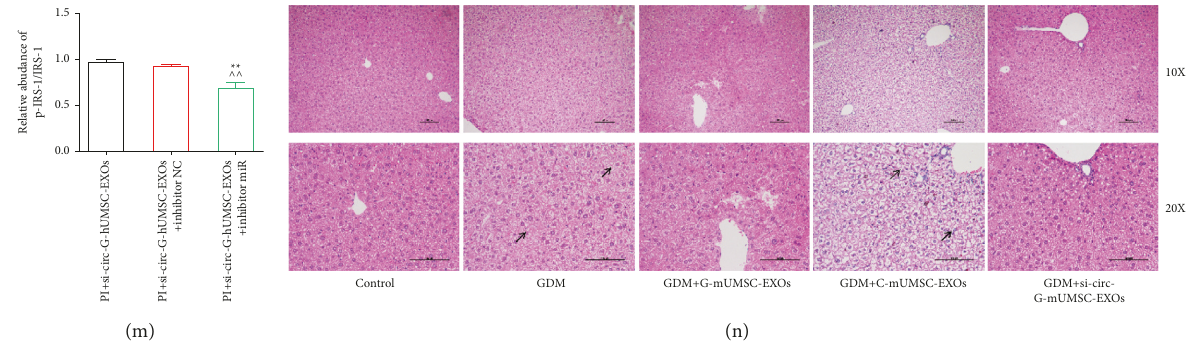
Figure 6: Exosomal hsa_circ_0046060 of hUMSC regulates glucose homeostasis and induces insulin resistance through hsa-miR-338-3p in vitro and in vivo. (a) mmu-miR-338-3p expression level (